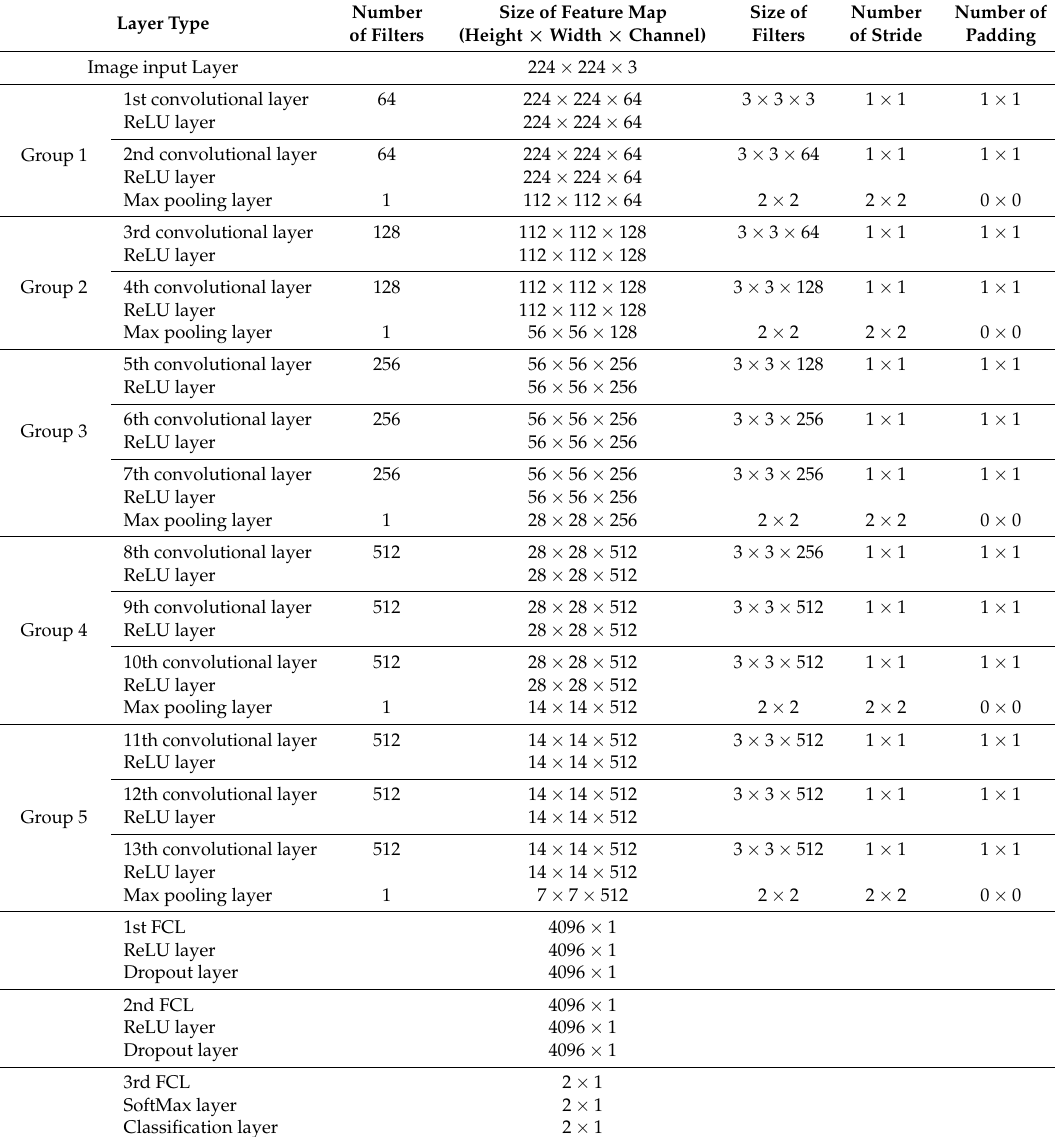
Table 2. Detail explanations of CNN